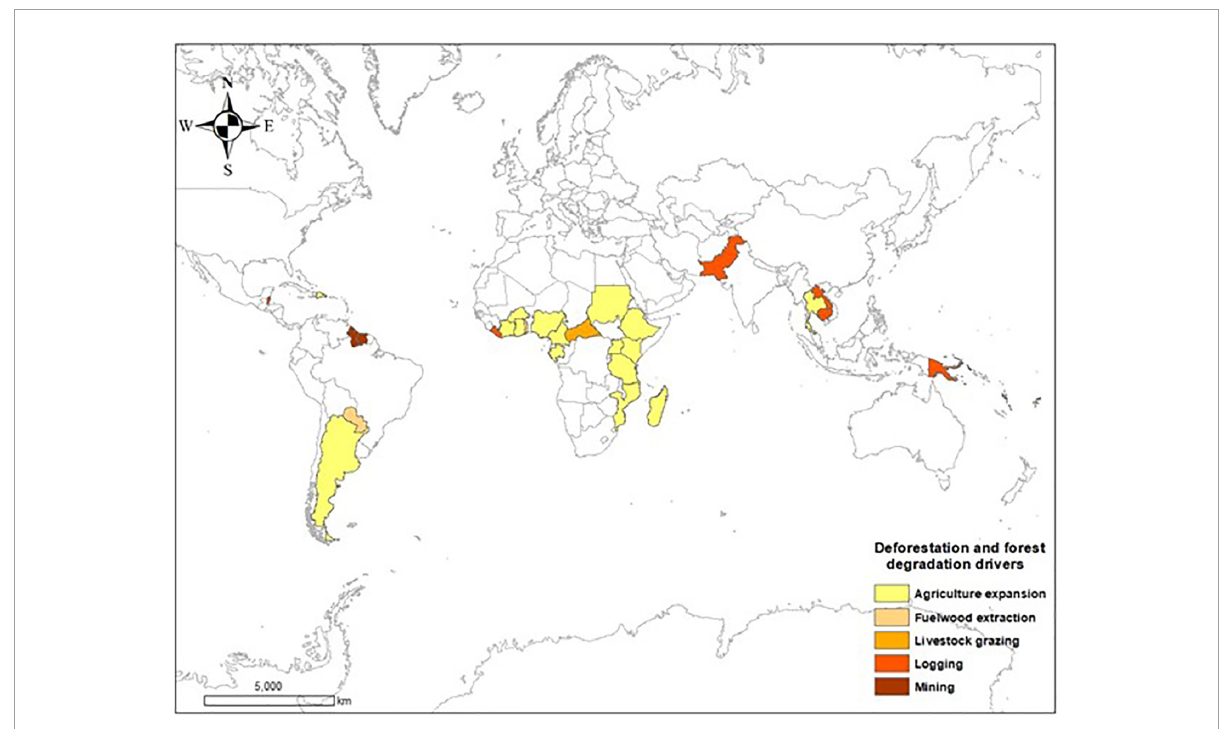
FIGURE2 Main direct drivers of deforestation and forest degradation as described by policymakers in 29 participant countries’